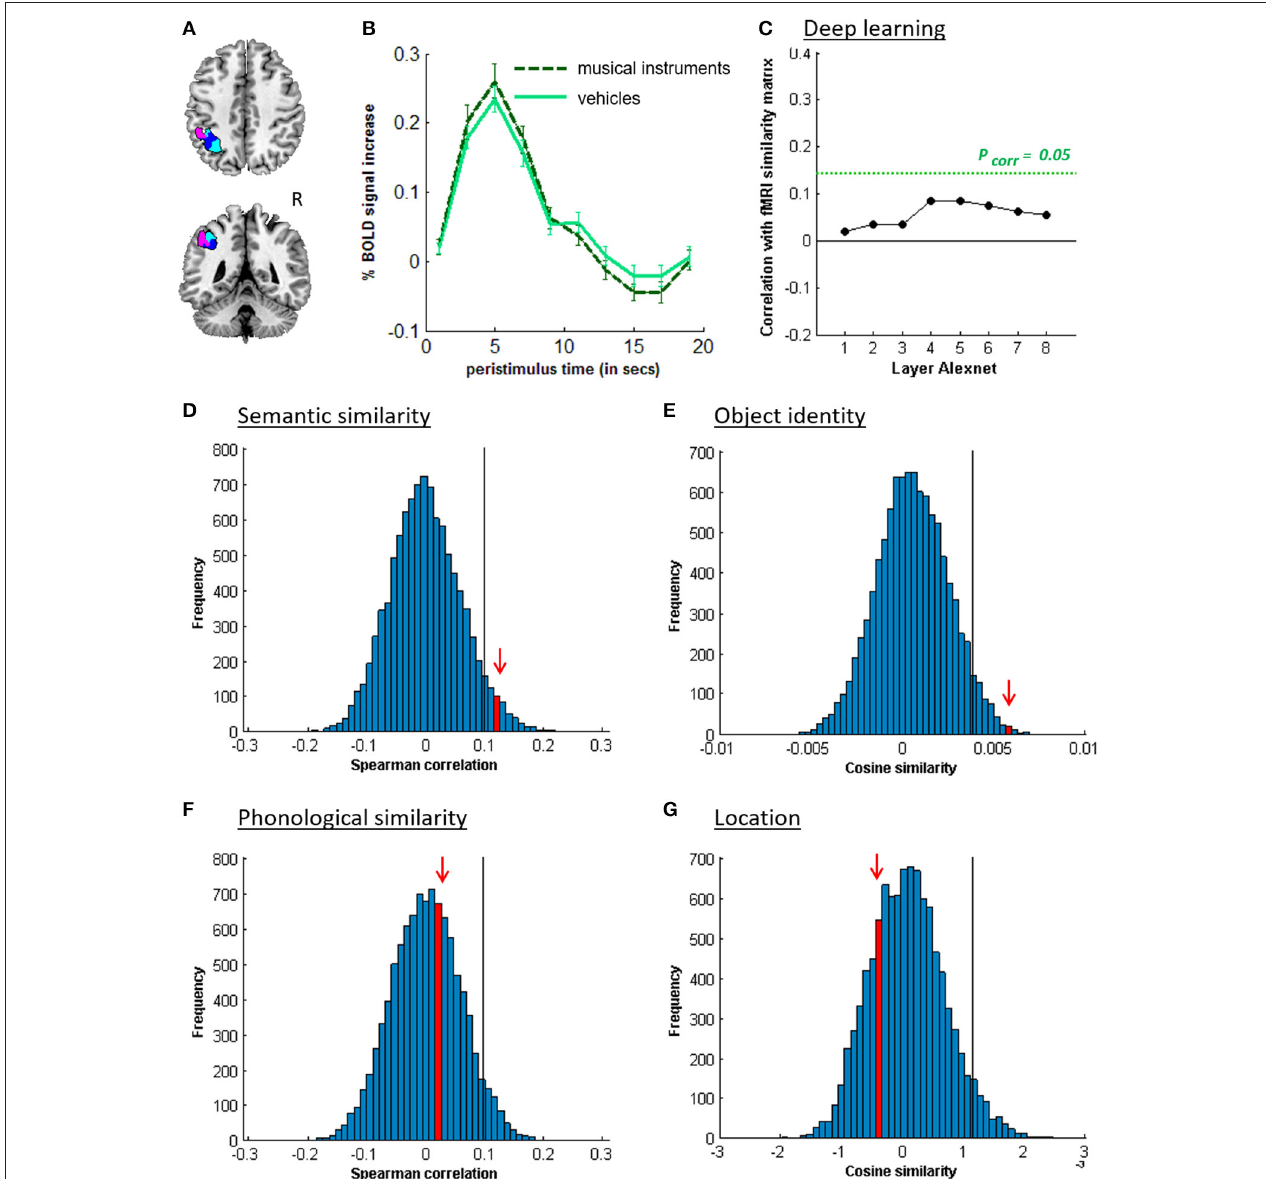
FIGURE 4 | MVPA effects in left middle IPS (hIP1-3). (A) Axial (z = 43) and coronal (y = − 46) slice depicting left middle IPS (hIP1, blue; hIP2, violet; hIP3; cyan). (B) Peristimulus respons for musical instruments and vehicles. (C) Deep Learning. Spearman correlation between the fMRI similarity matrix and the similarity matrices for the pictures for the eight layers of Alexnet. Statistical significance was evaluated by 10,000 random permutation labelings. The green dotted line corresponds to the statistical threshold corrected for the number of layers. (D) Probability distributions for the location-invariant semantic similarity effect. (E) Probability distributions for the location-invariant object identity effect. (F) Probability distributions for the phonological similarity effect. (G) Probability distributions for the object-invariant location effect. The red arrow indicates the true Spearman correlation/cosine similarity in the distribution of correlations/cosine similarities generated by 10,000 random permutations. X-axis: Spearman correlation averaged over the group of subjects. Y-axis: absolute frequency of a given average Spearman correlation value across all random permutation labelings. Black line: 95th percentile of the distribution.